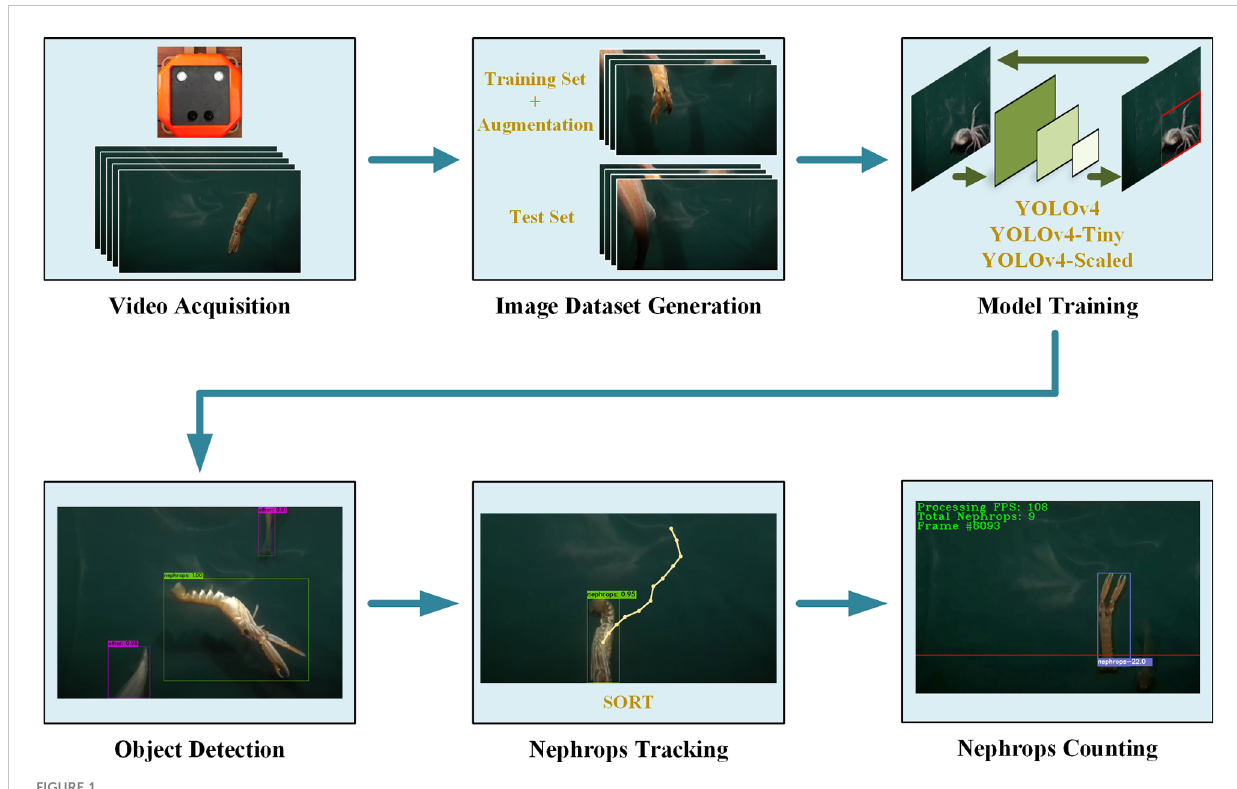
FIGURE 1 Overview of the algorithm